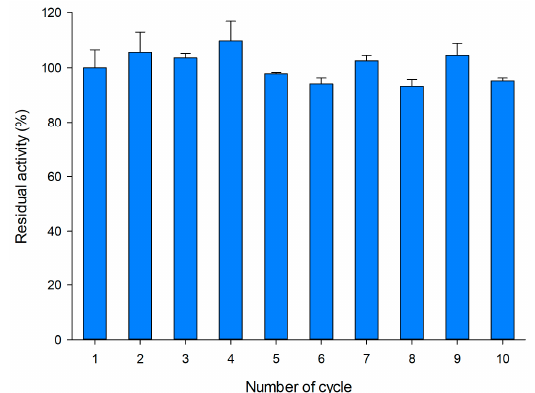
Figure 2. Operational stability of entrapped pXd-INV in PVA. Conditions for each cycle: 100 mg/mL sucrose, 50 °C, 20 min reaction.